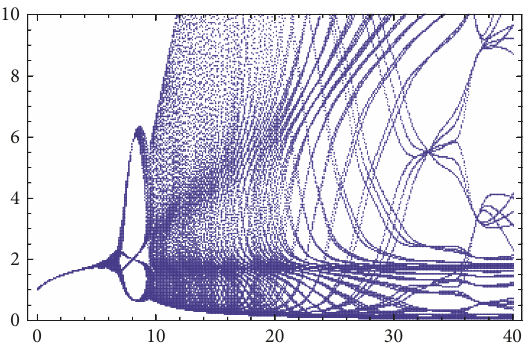
Figure 7: Bifurcation diagram in (𝐹,𝑥) plane for 𝑏 = 1 , 𝑐 = 1 , and 𝐵 = 2 , generated by Dynamica 4